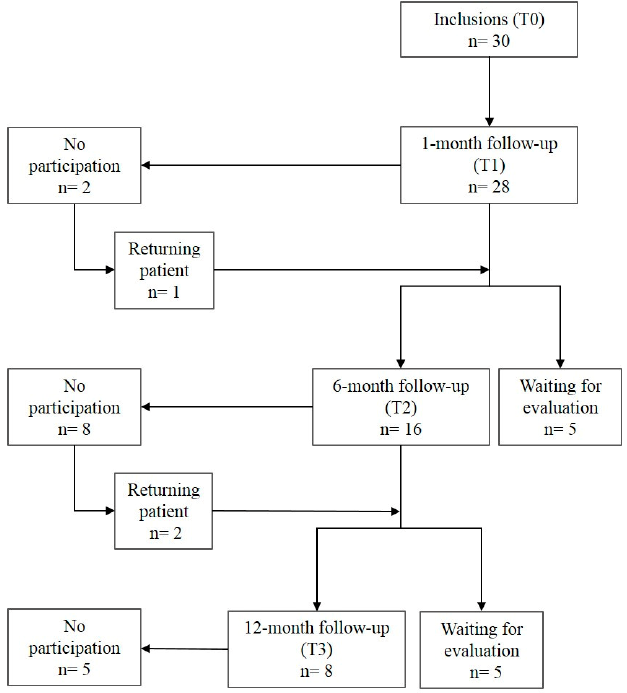
Figure 5. Flow chart of the study.